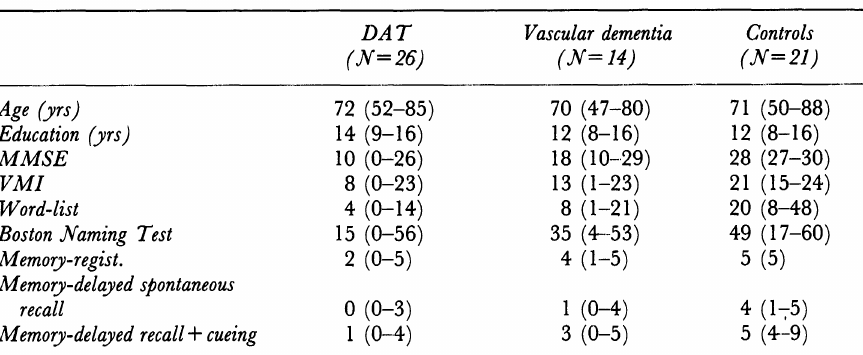
TABLE 2. Differences between means for all groups of subjects (t-test comparisons) DATvs Vascular dementia DATvs controls vs controls vascular